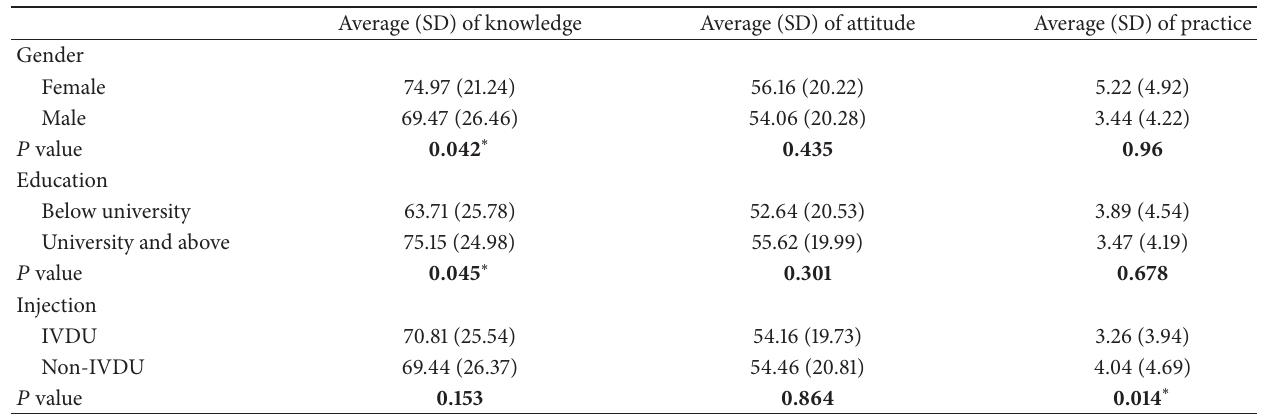
Table 6: KAP scores versus gender, education level, and